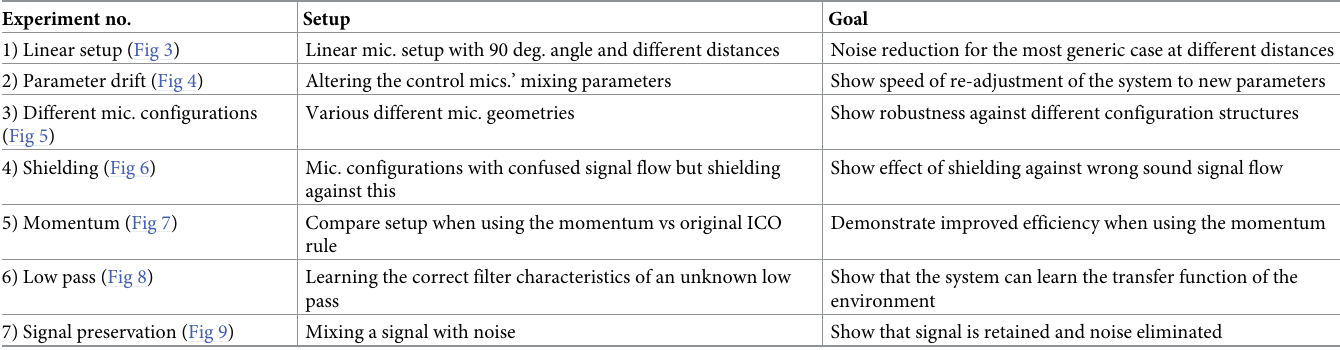
Table 1. Experiments and goals. Abbreviation ‘mic.’ stands for microphone. Experiment